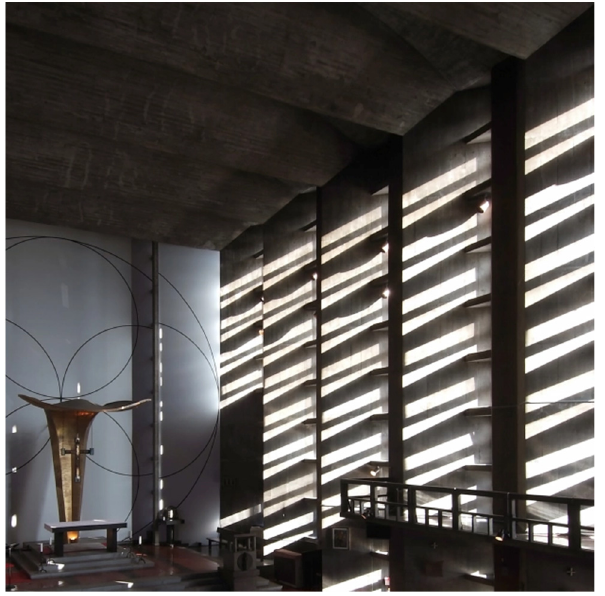
Figure 15. Staggering walls embedded with beams in the church of Sei Anselm.